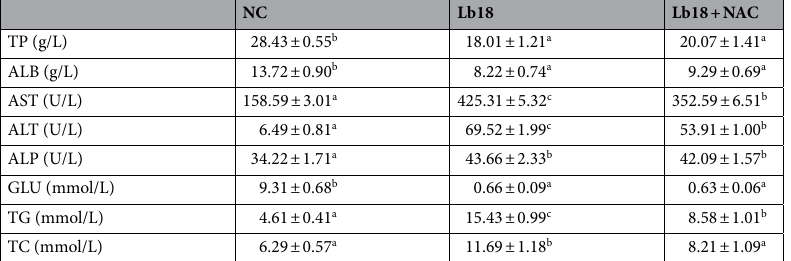
Table 3. Effects of physiological and biochemical characteristics of serum in each group. TP, total protein; ALB, albumin; AST, aspartate aminotransferase; ALT, alanine aminotransferase; ALP, alkaline phosphate; GLU, glucose; TG, triglyceride; TC, total cholesterol. Values represent the mean ± S.E. (n = 3 replicate tanks), 3 turtles were sampled for each tank. Values within the same row having different superscripts are significantly different ( p < 0.05).